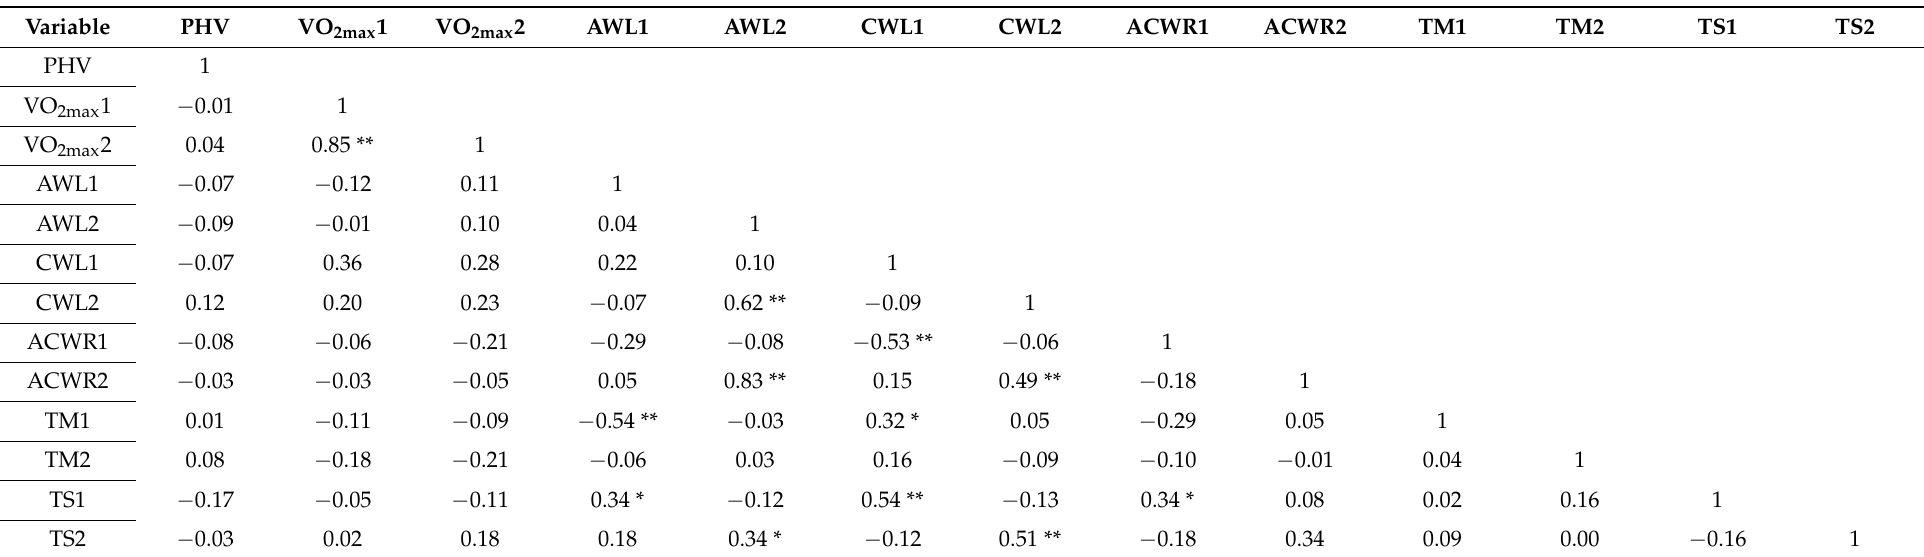
Table 3. Correlations between the peak height velocity, workload parameters, and locomotor